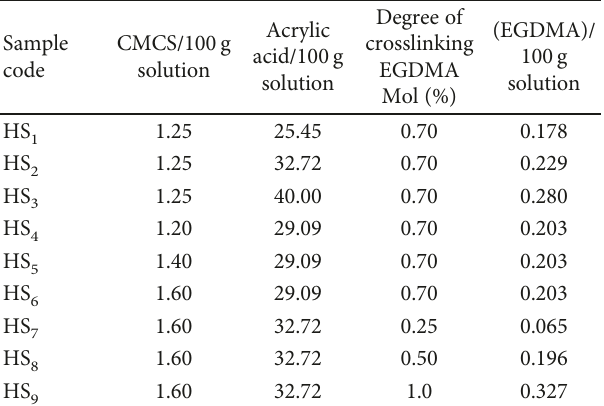
Table 1: Feed composition of Poly (CMCS- g -AA) hydrogels. Sample